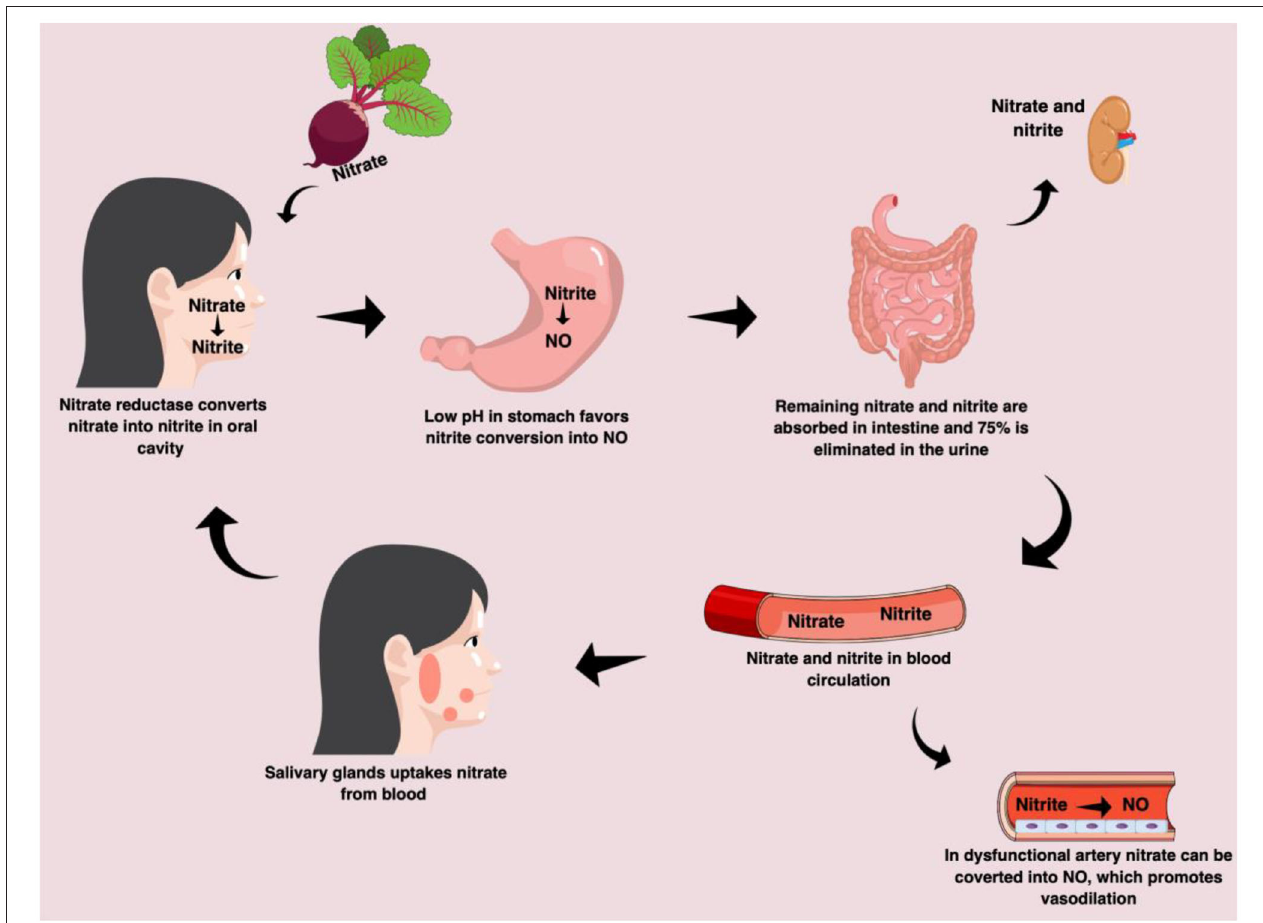
FIGURE 2 | Nitrate-nitrite-nitric oxide pathway in humans. After ingestion of nitrate-rich beetroot juice, the nitrate is converted into nitrite by nitrate reductase enzymes in the oral cavity. In the stomach, due to low pH the nitrite can be converted into nitric oxide. The remaining nitrate and nitrite are absorbed from the intestine and 75% is excreted in the urine. The nitrite absorbed from intestine into blood circulation can be converted into nitric oxide in dysfunctional